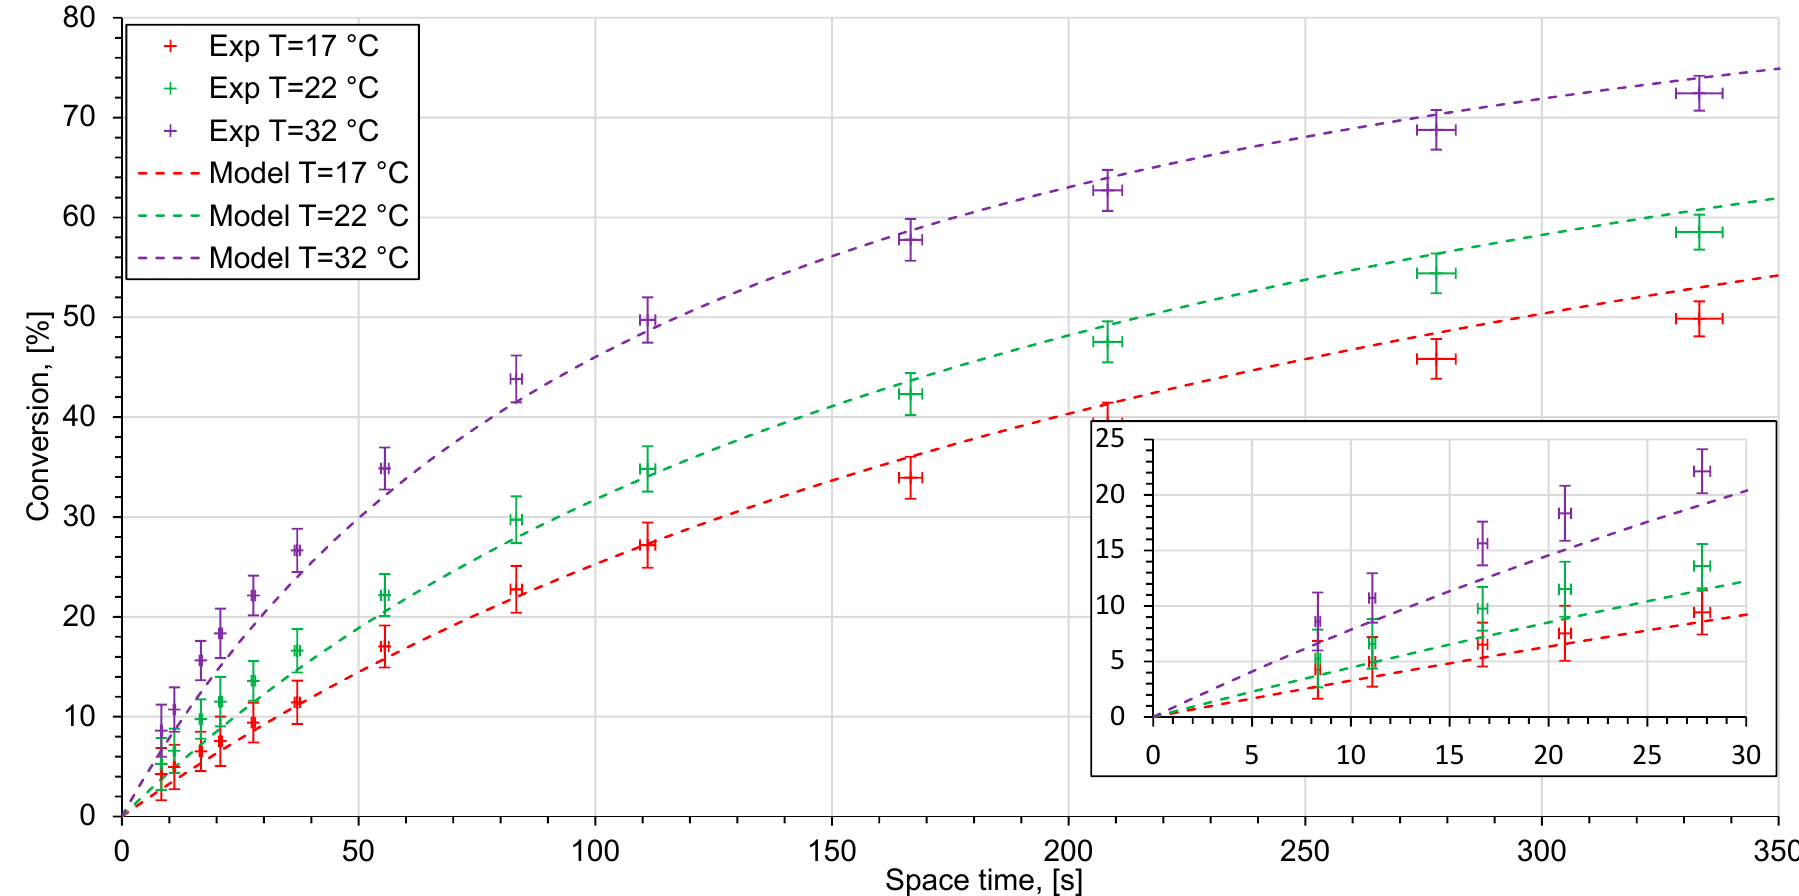
Figure 7. Experimental data (crosses) and kinetic model (dashed lines) at different temperatures in the reactor system with a T ‐ shaped reactor.